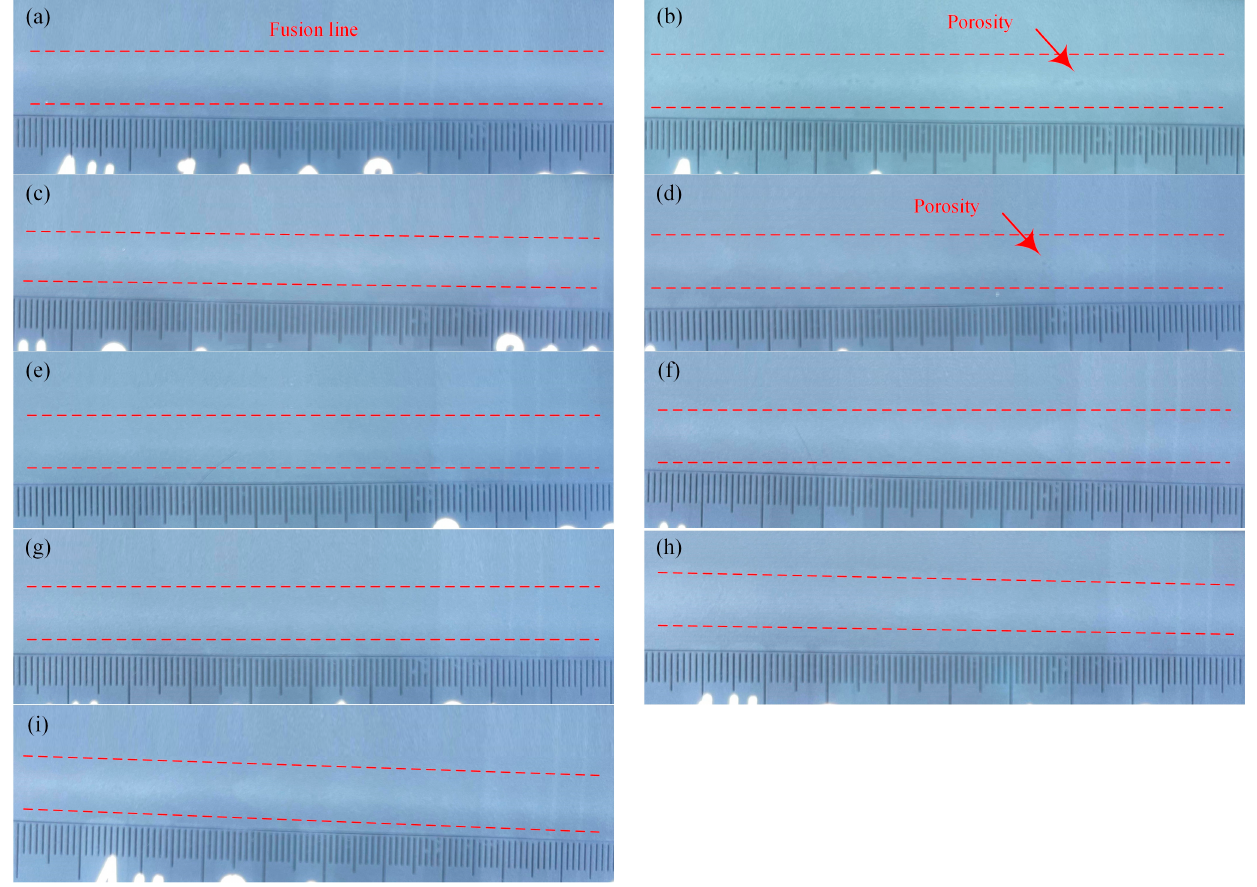
Figure 3. Porosity in the different weld seams of Table 3: ( a ) 1#; ( b ) 2#; ( c ) 3#; ( d ) 4#; ( e ) 5#; ( f ) 6#; ( g ) 7#; ( h ) 8#; and ( i ) 9#.